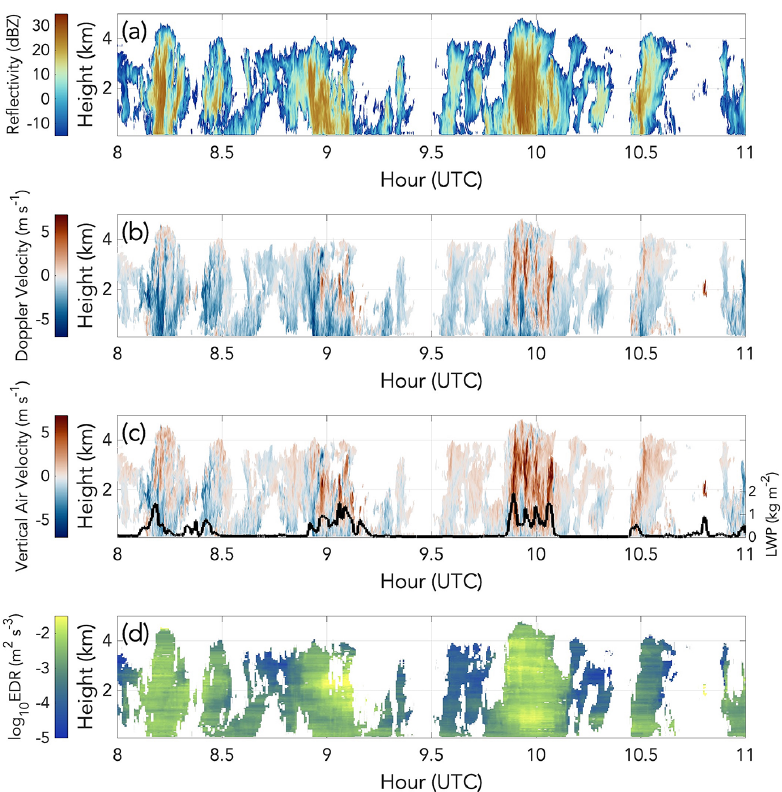
Figure 2. Time–height mapping from 08:00–11:00UTC on 28 March 2020 of (a) KAZR radar reflectivity, (b) KAZR Doppler velocity, (c) retrieved vertical air velocity and liquid water path, and (d) retrieved eddy dissipation rate. Prepared using Crameri (2021).